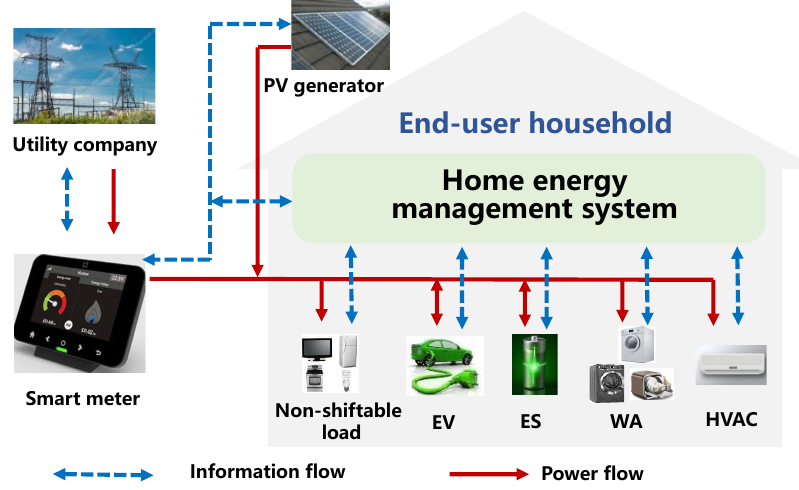
Figure 1. Schematic representation of the investigated household operating multiple and diverse